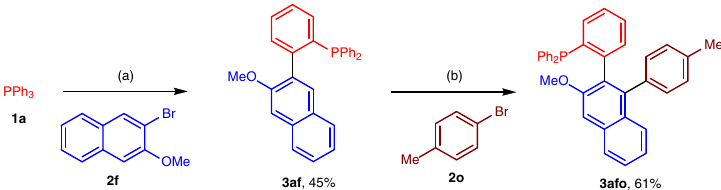
Fig. 5 Twofold direct arylation of PPh 3 (1a) with two different aryl bromides. Reaction conditions: a [Rh(cod)Cl] 2 (2.5 mol %), 1a (0.2 mmol), 2f (0.6 mmol), K 2 CO 3 (1.0 mmol) in 1,4-dioxane (0.3 mL) at 120 °C for 12 h, under argon. b [Rh(coe) 2 Cl] 2 (5.0 mol %), 3af (0.1 mmol), 2o (0.3 mmol), K 2 CO 3 (0.5 mmol) in 1,4-dioxane (0.25 mL) at 150 °C for 36 h, under argon.